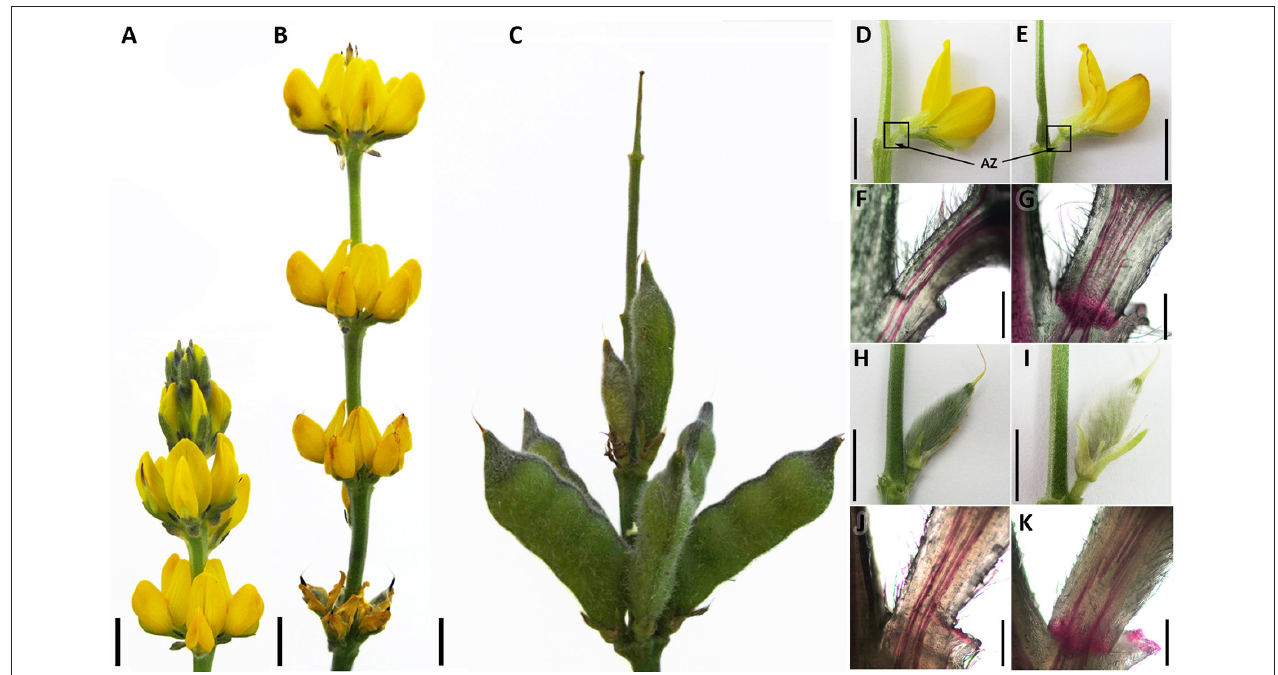
FIGURE 2 | Generative organs of Lupinus luteus cv. Taper. Inflorescence development (A–C) . Developing and abscising flowers, (D,E) , respectively. Localization of harvested flower pedicels and abscission zones (AZ) indicated by squares and arrows, respectively. Cross-section view of developing and abscising flower pedicels after Phloroglucinol–HCl staining, (F,G) , respectively. View of developing and abscising pods, (H,I) , respectively. Cross-section view of developing and abscising pod pedicels after Phloroglucinol–HCl staining, (J,K) , respectively. Black line − 1 cm bar for (A–E , H,I) , 600 nm bar for (F,G,J,K)